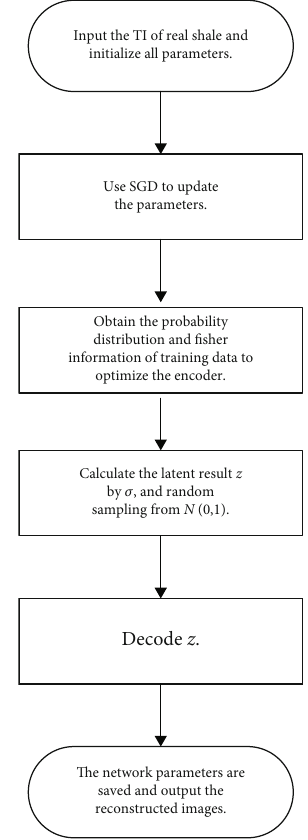
Figure 3: The fl owchart of the proposed